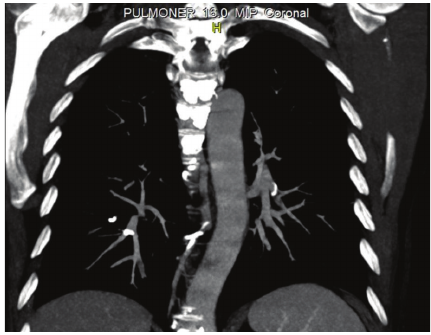
Figure 4: Coronal view of thorax